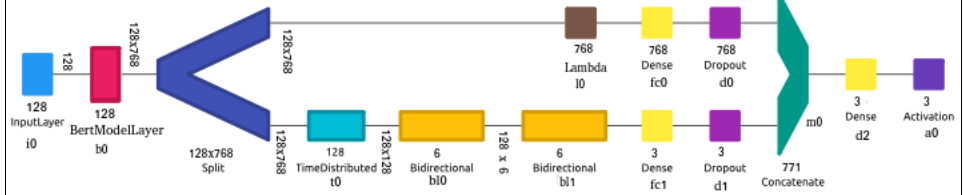
Figure 3. BERT-based network.